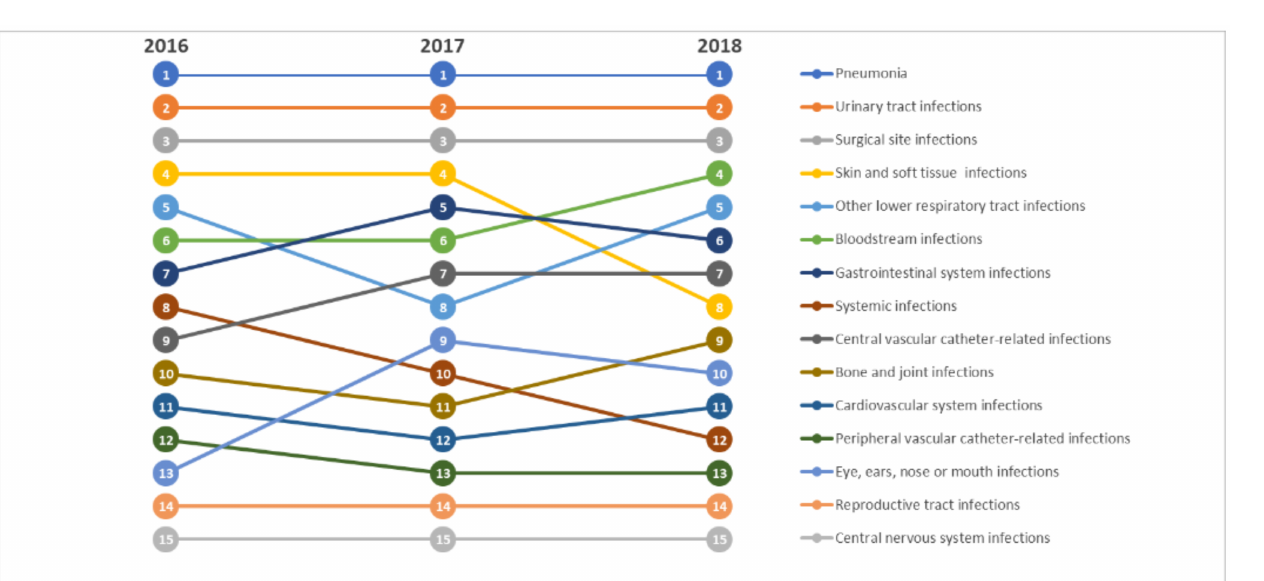
Figure 1. Ranking of types of HAI by year of the Point Prevalence Survey.